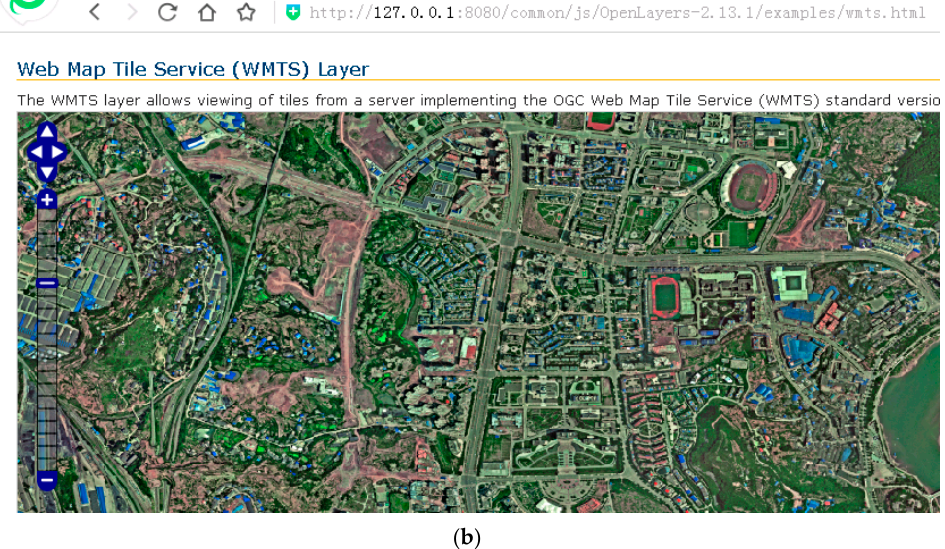
Figure 14. The server can be used to quickly publish vector and image data on the data cluster (on-the-fly). ( a ) Viewing vector data in a data cluster published on the server side in real time at a small scale. The viewed data can be automatically cached, and thus the more browsing visits that occur, the more efficient the service response is. The initial server needs to request the data entity in the data cluster. ( b ) Visiting a global entity image of Dazhou City, Sichuan Province, released by the server. Unlike vector dynamic rendering, the efficiency of accessing physical images depends mainly on the IO speed of the network and the hard disk.